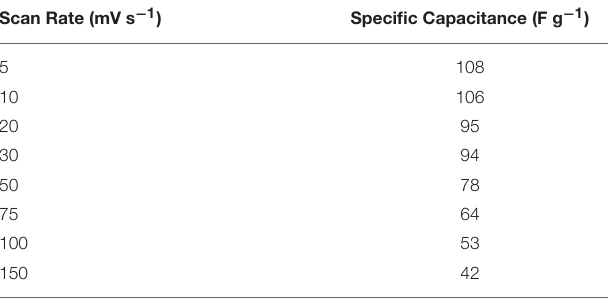
TABLE 1 | Specific capacitance of hollow and porous NaFePO 4 form CV curves in 2M NaOH electrolyte.